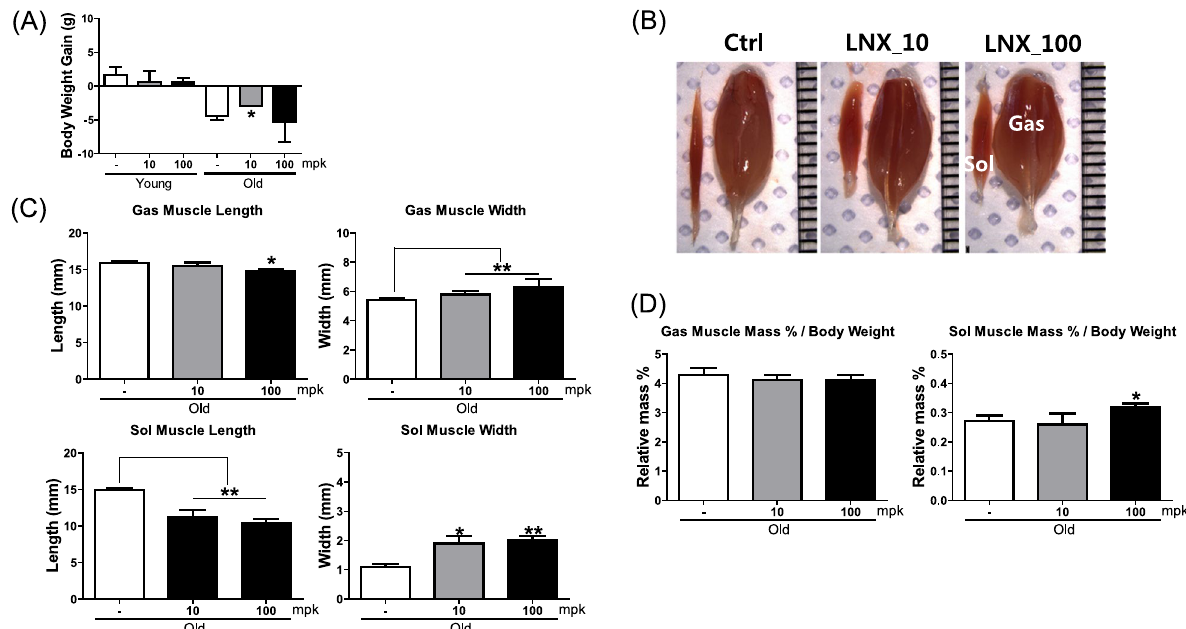
Fig. 1 Phenotypical and anatomical changes of LNX‑fed mice. A Body weight gain. B Images of dissected gastrocnemius (Gas) and soleus (Sol) muscles. Each gradation on a rule is 1 mm scale. C Dimensions of dissected Gas and Sol muscles. D Weight of each Gas and Sol muscle divided by body weight. Data represent the mean standard deviation of triple or quadruple experiments. Statistical significance * p < 0.05, ** p < ±